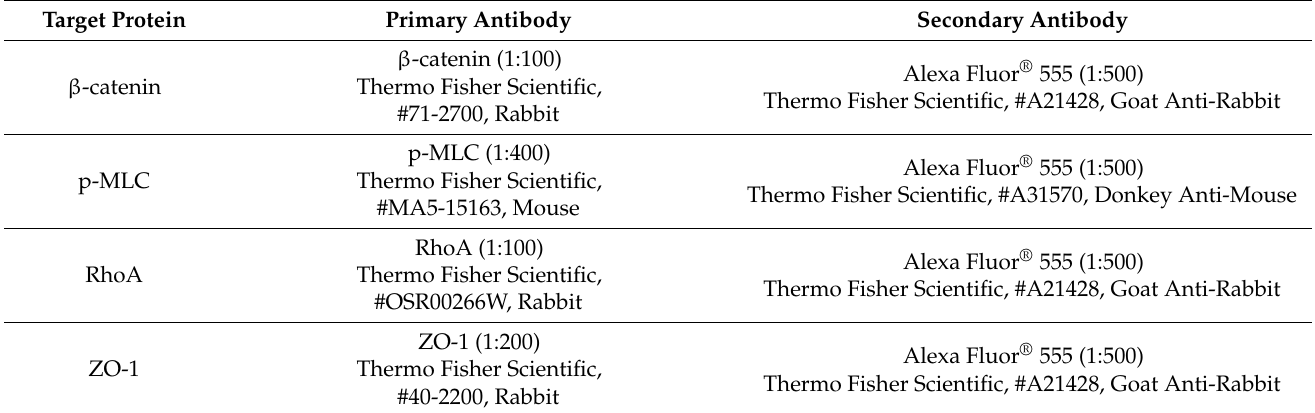
Table 1. Summary of the experimental conditions for immunofluorescence